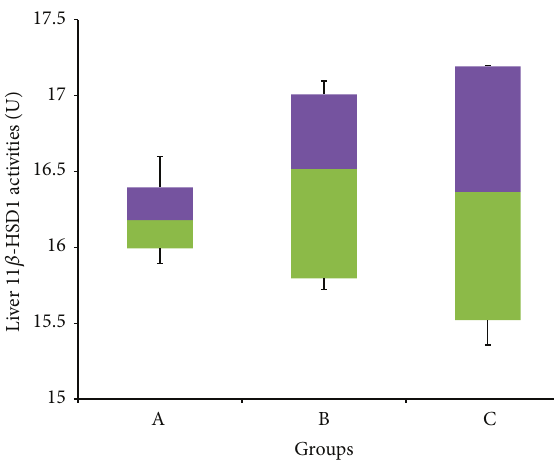
Figure 7: 11 𝛽 -HSD 1 activities in the liver of rats in Groups A, B, and C at the end of the four-week treatment period. Group A: control (HSD/HFD); group B: stress + HSD/HFD; group C: stress + GA + HSD/HFD. Abbreviations: GA: glycyrrhizic acid, HSD: high- sucrose diet, and HFD: high-fat diet.